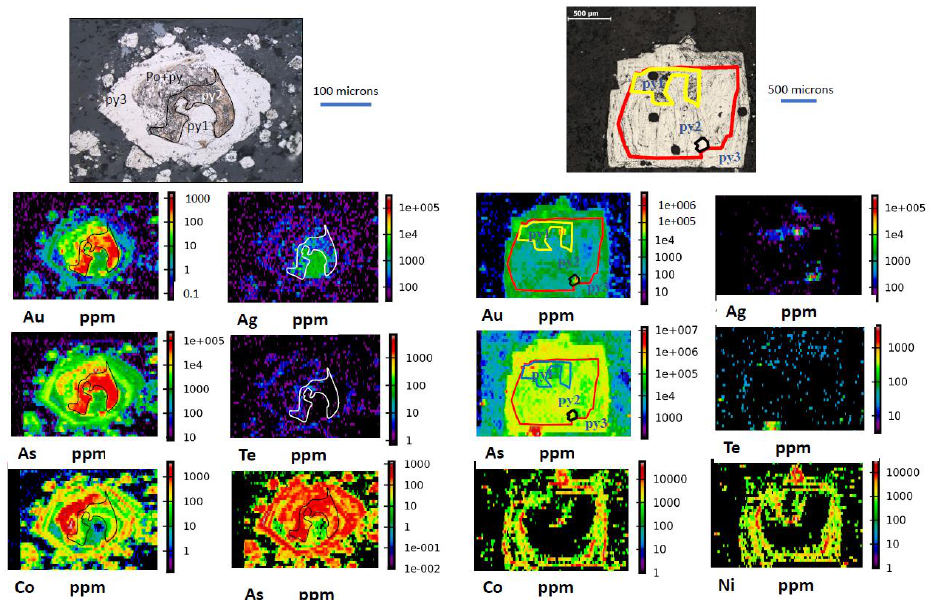
Figure 8. ( A ) LA-ICPMS maps in ppm of complex pyrite aggregate from the Konkera Deposit. Py2 carries the maximum Au and As, with an outer zone enriched in Ni, Co and As, but lesser Au. ( B ) A typical pyrite from Macraes Deposit with LA-ICPMS maps in cps. Three pyrite zones py1, py2, py3 all carry significant Au, As but no Te or Ag. Nickel and Co concentrated in the outermost py3. Free Au micro-particles are indicated by red spots on the Au map.